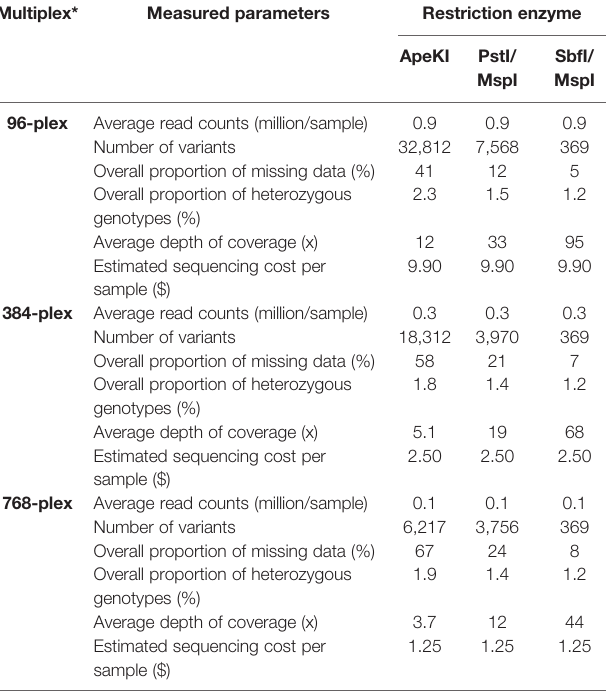
TABLE 2 | Results of genotyping-by-sequencing using different multiplexing conditions and library preparation protocols.